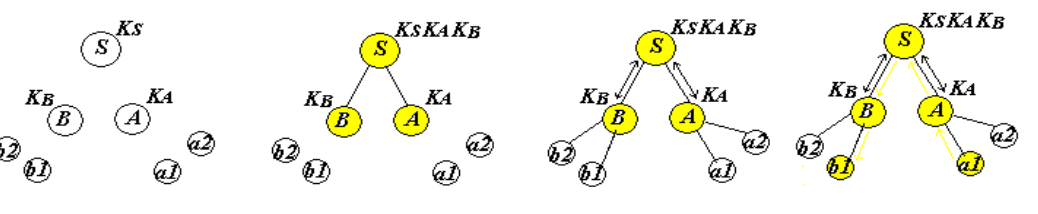
Figure 4. Indirect Connection